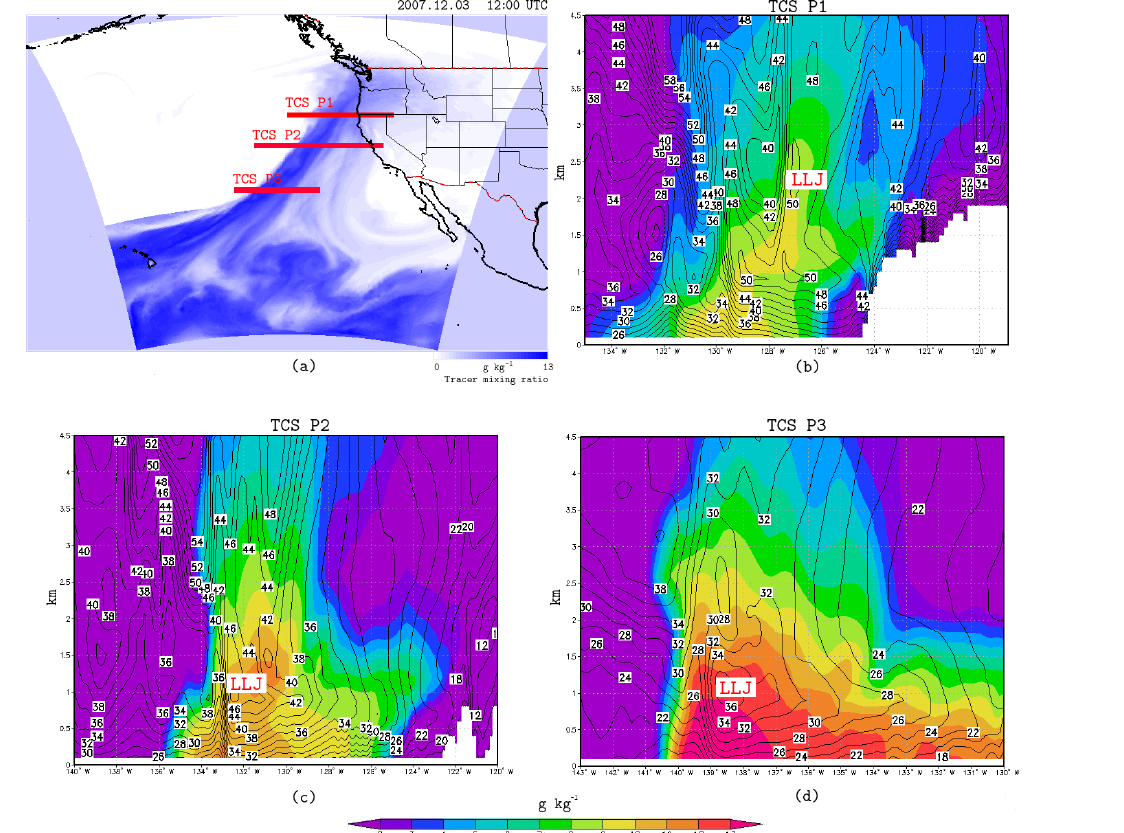
Figure 8. Transversal cross sections along the central axis of the atmospheric river at latitudes 42.0 (transversal cross section P1), 37.4 (transversal cross section P2) and 30.6 (transversal cross section P3). The plots show the tracers’ water vapor mixing ratio in grams per kilogram together with the wind module in meters per second. The estimated position of the LLJ is shown in the figures as